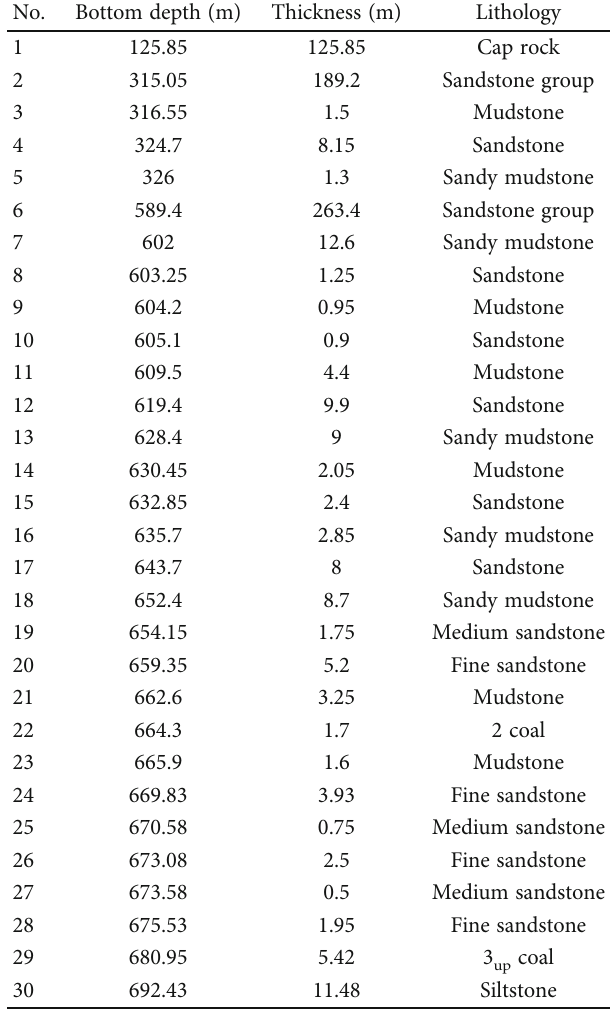
Table 1: Lithology of overlying strata above the coal seam (O2-D7 drilling